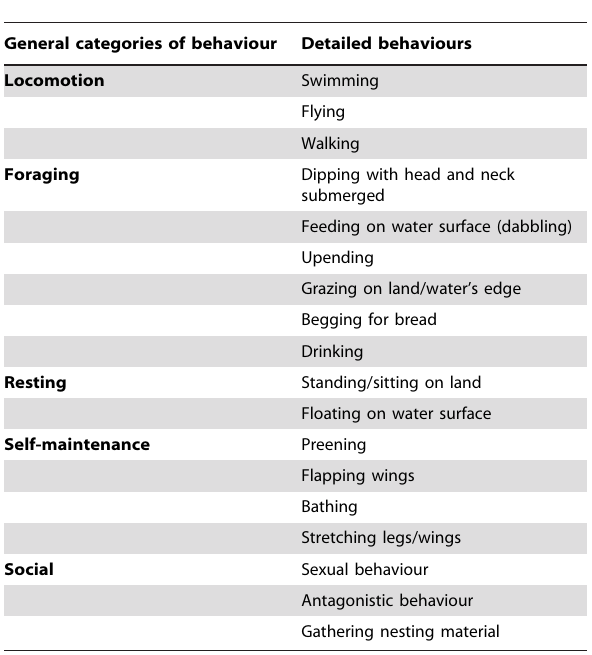
Table 1. Behaviours recorded for black swan observations at Albert Park